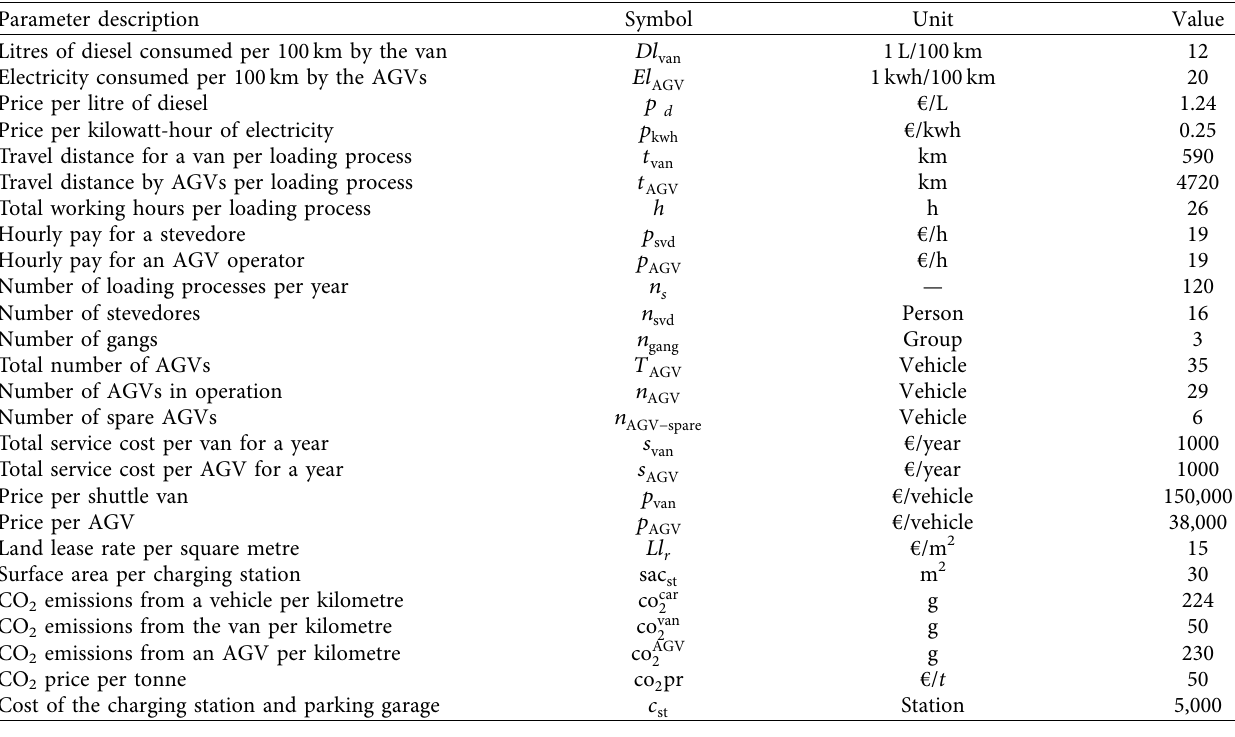
Table 3: Parameters of the cost model and their